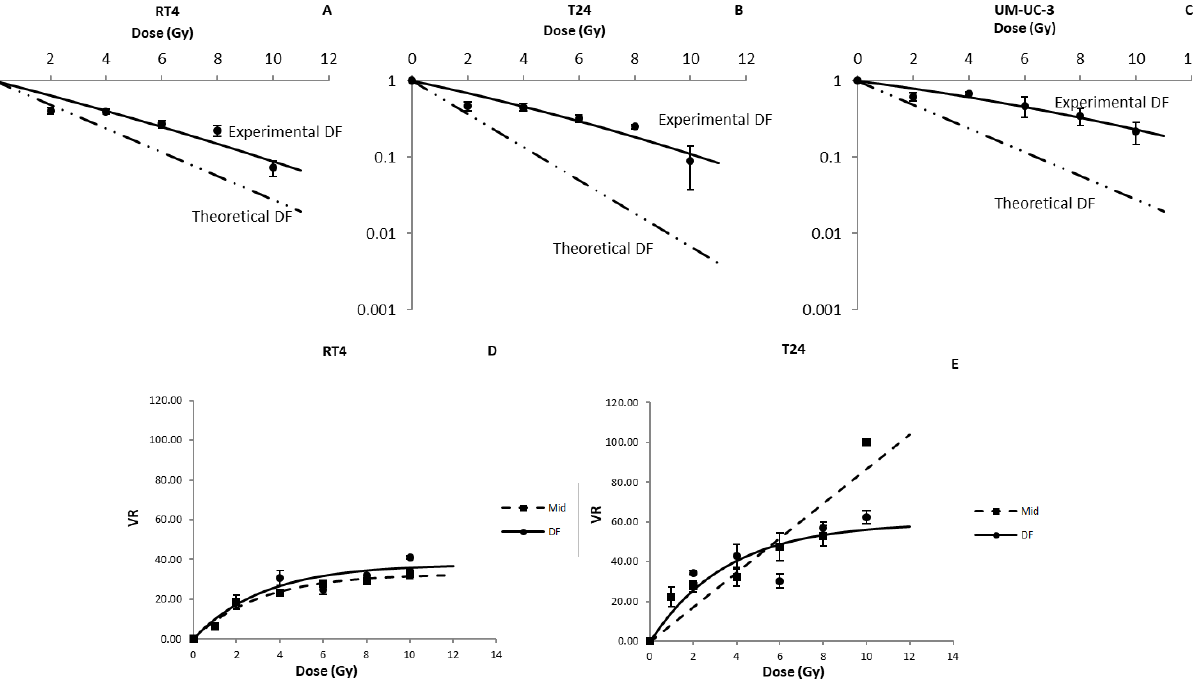
Figure 6. Effect of dose fractionation on the radiosensitivity of bladder cancer cell lines in 3D. Radio-induced decrease in the sphere ratio (SR) for RT4 ( A ), T24 ( B ) and UM-UC-3 ( C ), and Volume reduction (VR) for RT4 ( D ) and T24 ( E ) human bladder cancer cell lines after performing a dose fractionated treatment protocol. Data represents the mean of at least three independent experiments ± SEM. Fitting parameters and the corresponding R 2 values are shown in Table 2.